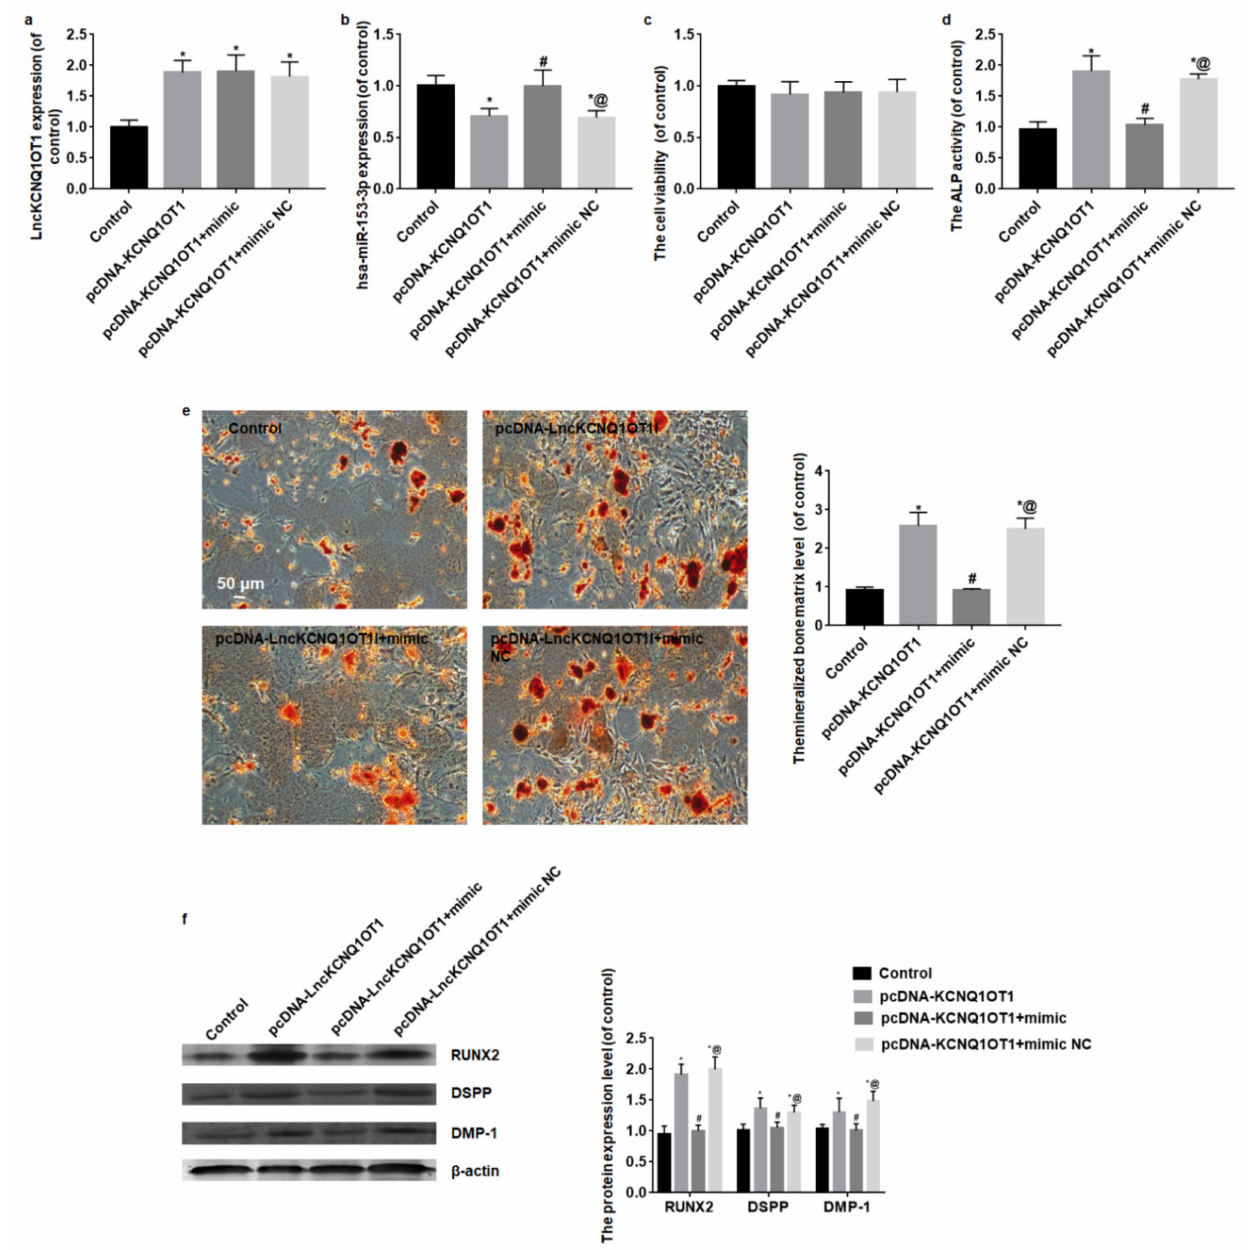
Figure 3. Overexpression of hsa-miR-153-3p reverses the promotion of odontoblastic differentia- tion induced by LncKCNQ1OT1. ( a ) LncKCNQ1OT1 expression level of DPSCs transfected with pcDNA-KCNQ1OT1, pcDNA-KCNQ1OT1+mimic or pcDNA-KCNQ1OT1+mimic NC significantly increased. ( b ) hsa-miR-153-3p expression level of DPSCs transfected pcDNA-KCNQ1OT1 or pcDNA- KCNQ1OT1+mimic NC significantly decreased, and hsa-miR-153-3p expression level of DPSCs transfected with pcDNA-KCNQ1OT1+mimic was similar to the control group. ( c ) The results of CCK-8 assay showed the transfection did not affect the viability of DPSCs. ( d – f ) After 14 days of odontoblastic differentiation, the ALP activity, mineralized bone matrix, RUNX2, DSPP, and DMP-1 protein expression levels in the pcDNA-KCNQ1OT1 group increased comparison with the control group. While DPSCs were co-transfected with pcDNA-KCNQ1OT1 and hsa-miR-153-3p mimic the ALP activity, mineralized bone matrix, RUNX2, DSPP, and DMP-1 protein expression levels were close to the control group. Bar = 50 µ m. * vs. control group, p < 0.05; # vs. pcDNA-KCNQ1OT1 group, p < 0.05; @ vs. pcDNA-KCNQ1OT1+mimic group, p <